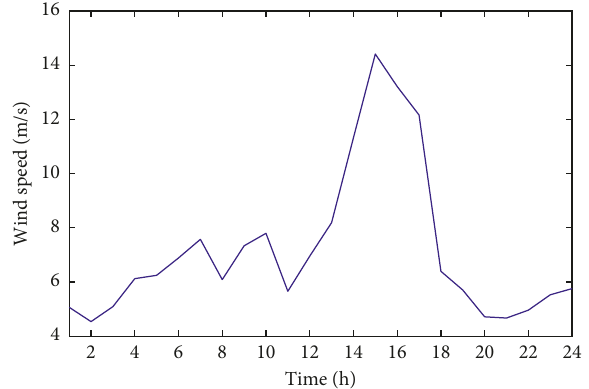
Figure 6: Wind resource data.